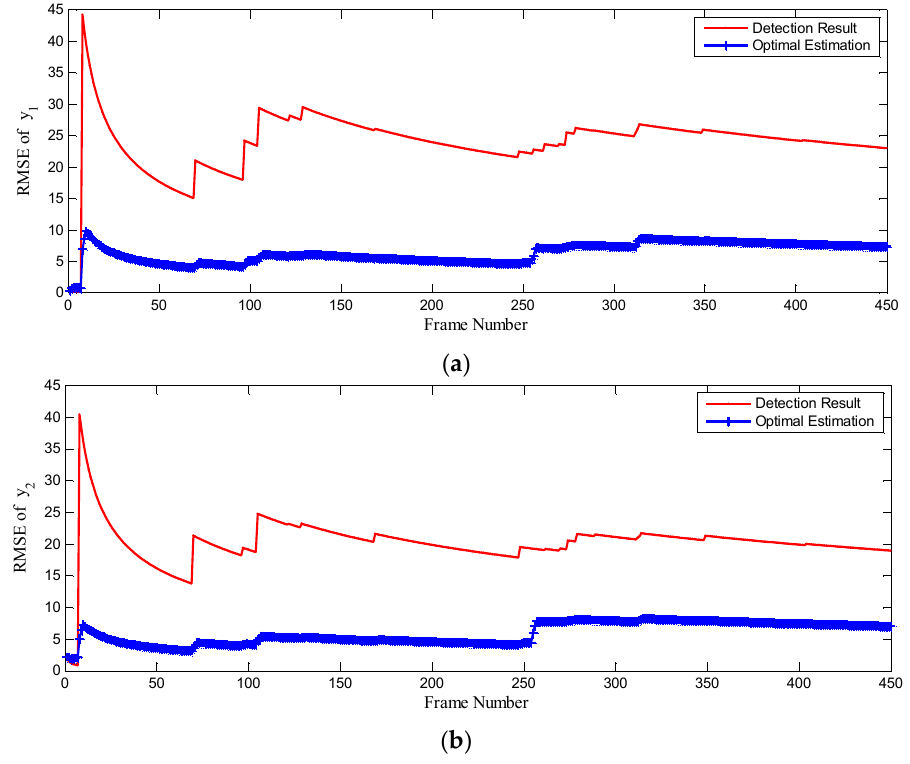
Figure 14. The RMSE comparison of detection results and state estimation by CKF. ( a ) is RMSE of detection results and state estimation of vertical coordinate y 1 ; ( b ) is RMSE of detection results and state estimation of vertical coordinate y 2